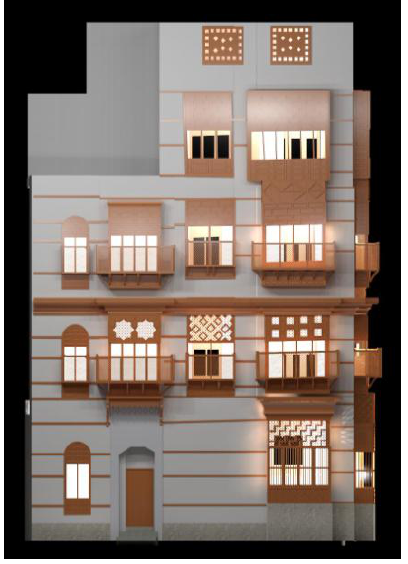
Figure 15. Rendering West Elevation from